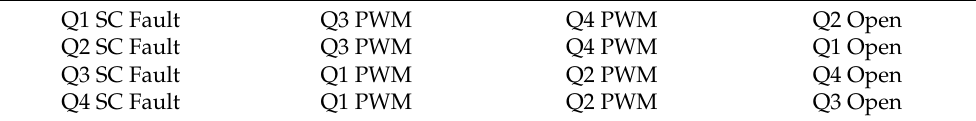
Table 2. FB to HB reconfiguration logic.